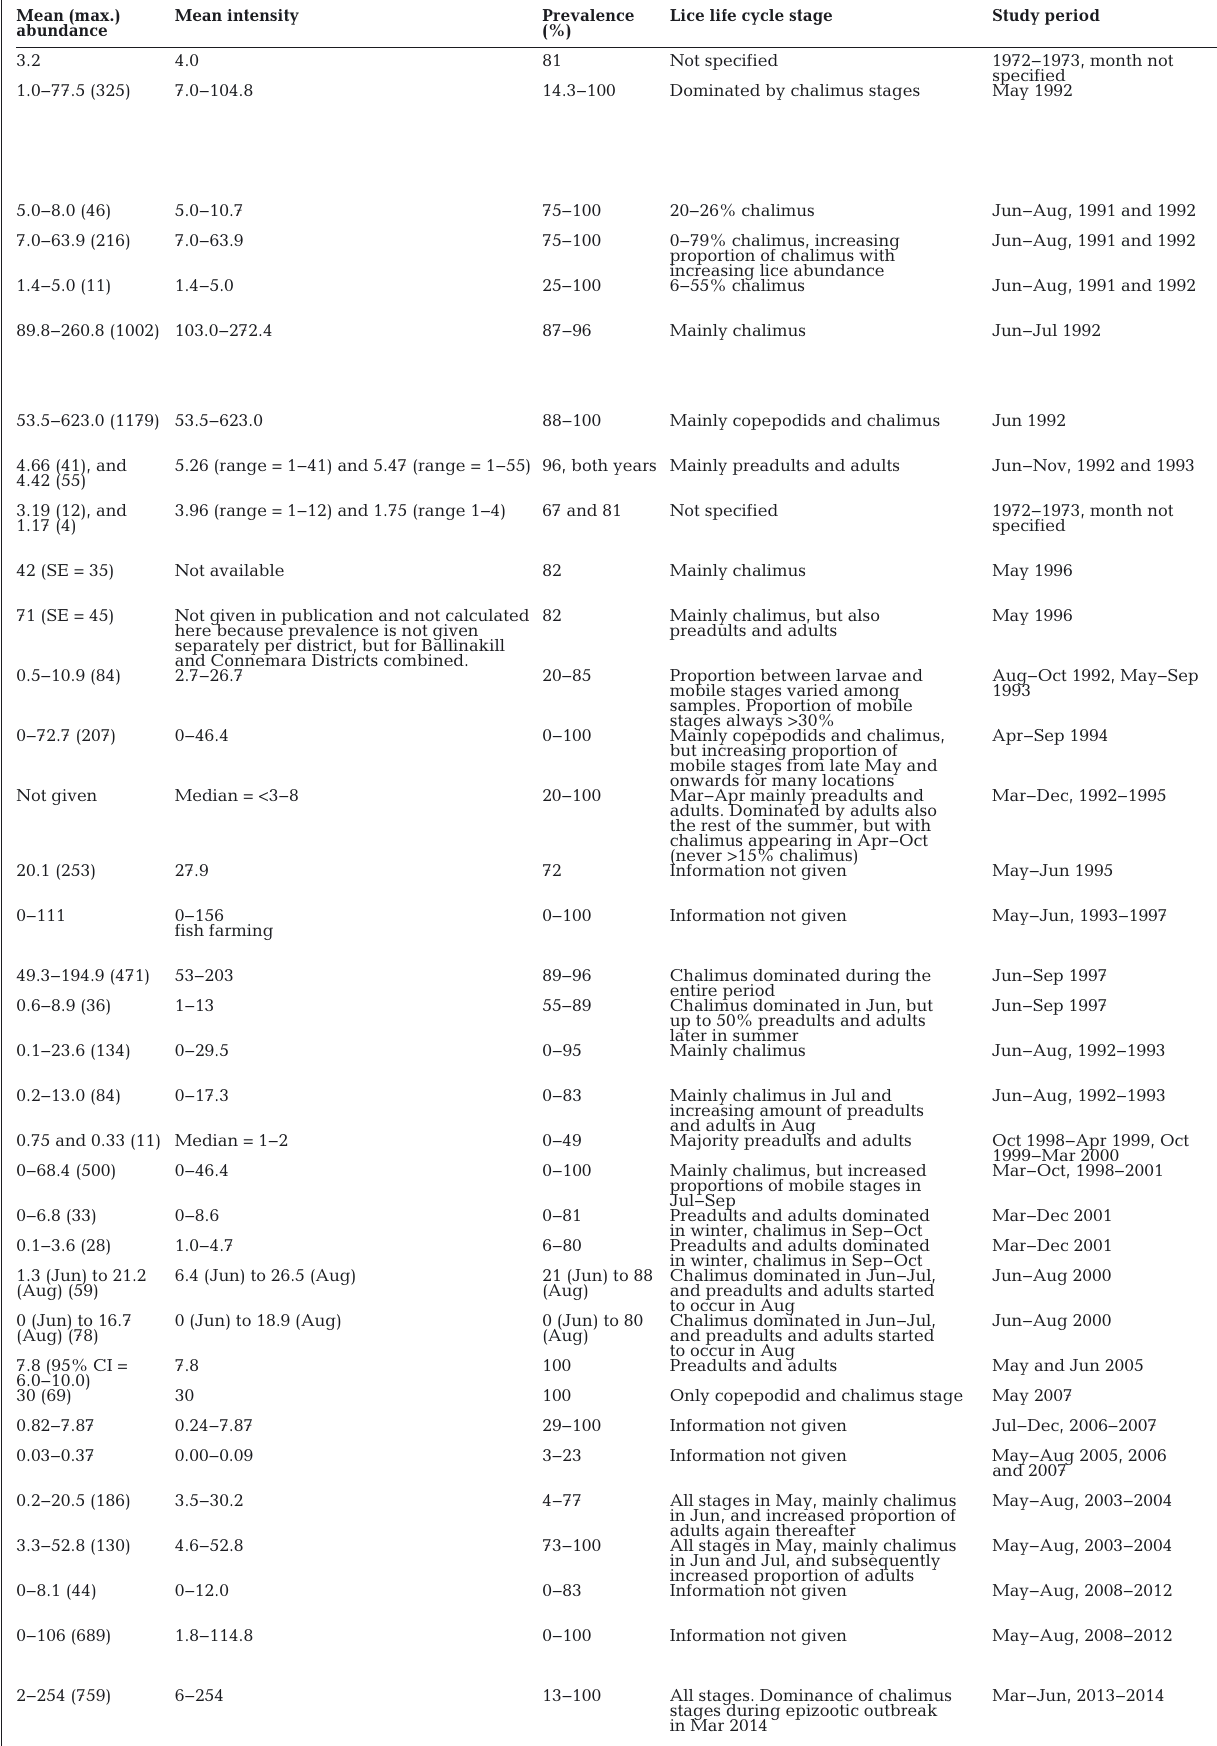
Table 1. Summary of salmon lice levels found on wild sea trout in the current literature, showing the mean abundance of salmon lice per fish caught per sample (max. number of lice on an individual sea trout is given in parentheses where data available), mean (median where specified) intensity of salmon lice per infested fish in the sample, and percentage